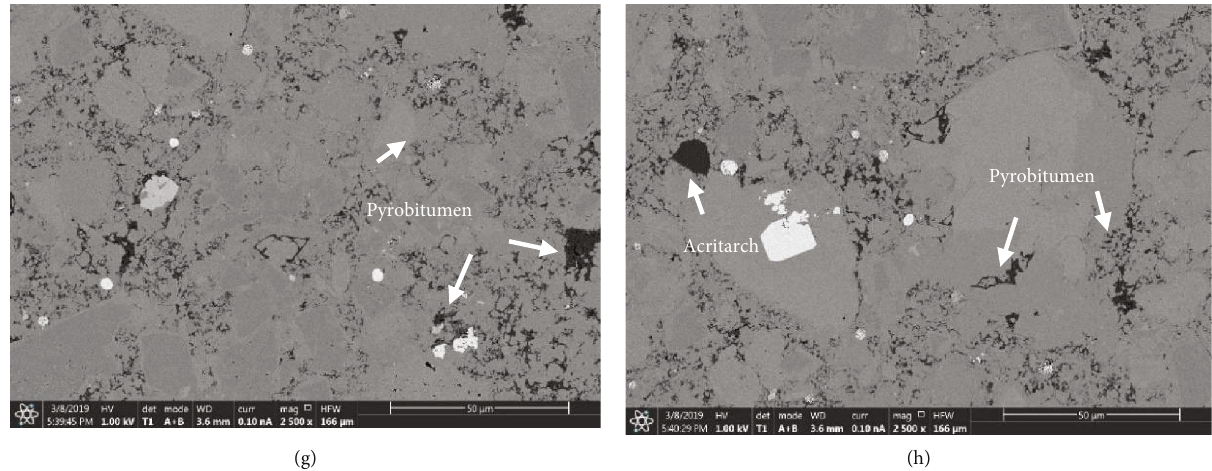
Figure 11: SEM images showing maceral types and related pores observed in Wufeng-Longmaxi shales. (a – h) Selected samples under SEM at depths of 2481 m, 2503m, 2513 m, 2534 m, 2567m, 2573 m, 2576 m, and 2577 m, respectively. The organic matter content increases with deeper depth (a – h) in the studied samples and can be re fl ected by the area of dark material (a – h). Pyrobitumen is the dominant maceral in samples, and its content shows an obvious increase in samples from 2567 m deep and